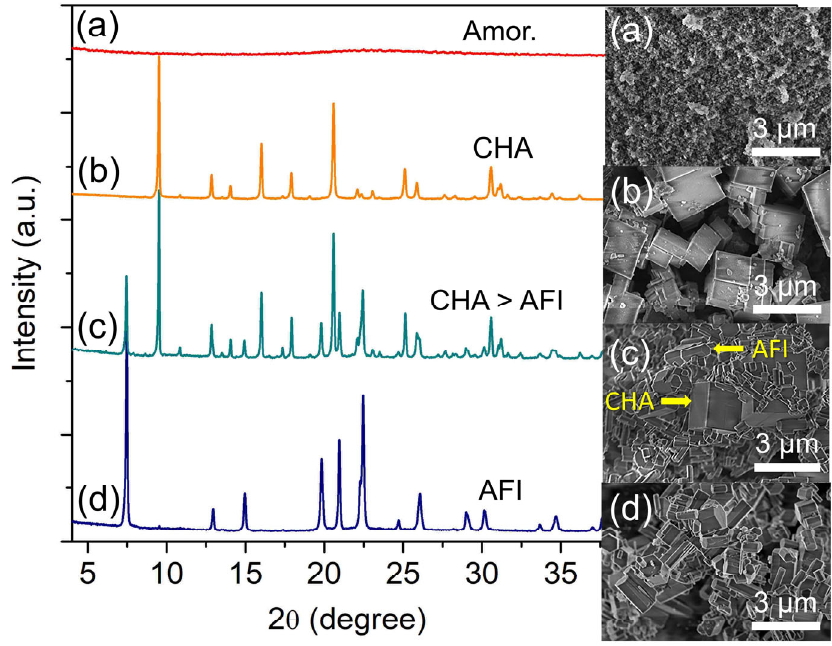
Figure 2. XRD patterns and FESEM micrographs of ( a ) S-5 ( w = 4.1), ( b ) S-3 ( w = 4.7), ( c ) S-6 ( w = 5.3), and ( d ) S-7 ( w = 5.9) samples. The samples were prepared using a hydrogel of 2.0 Al: w P: 0.9 Si: 6.7 [PrPy]OH: 148 H 2 O heated at 200 ◦ C for 19 h.